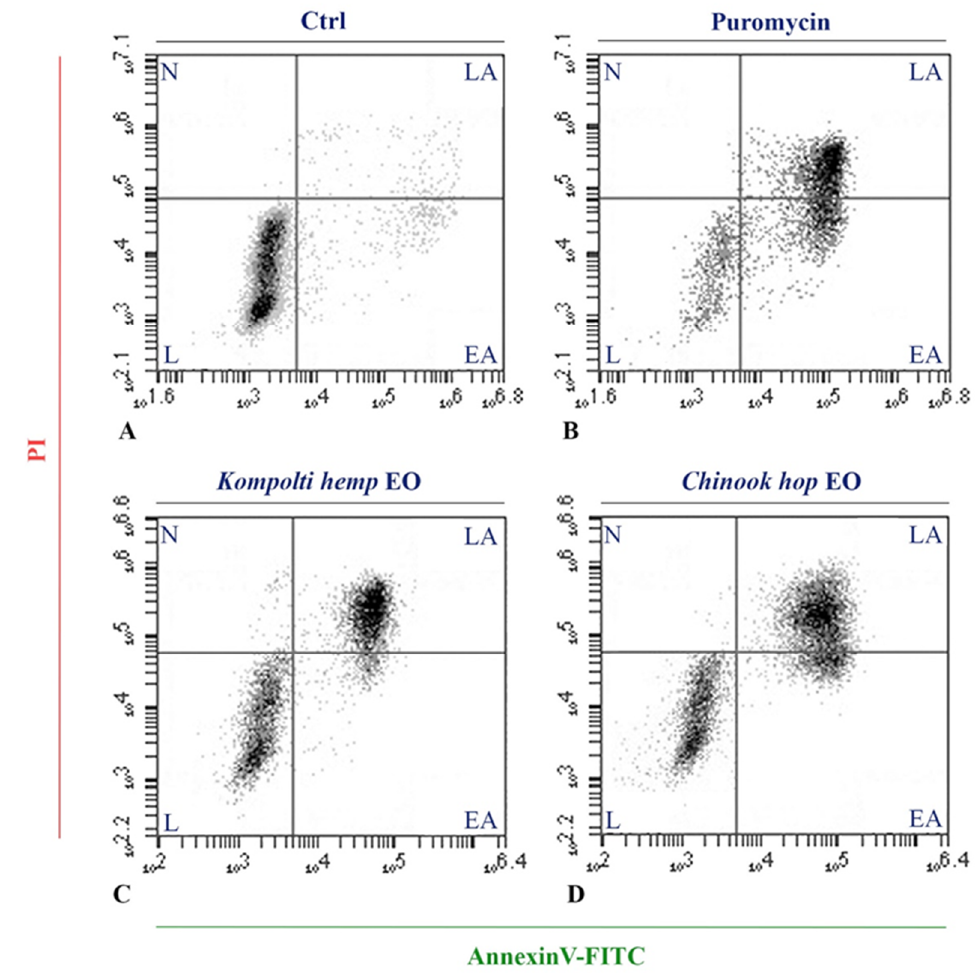
Figure 4. Flow cytometric analysis of the Kompolti hemp and Chinook hop EOs treatments on HL60 cells for apoptosis determination using AnnexinV-FITC/PI staining. ( A ): Ctrl; ( B ): Puromycin; ( C ): Kompolti hemp EO; ( D ): Chinook hop EO. L: live cells; EA: early apoptotic cells; LA: late apoptotic cells; N: necrotic cells.